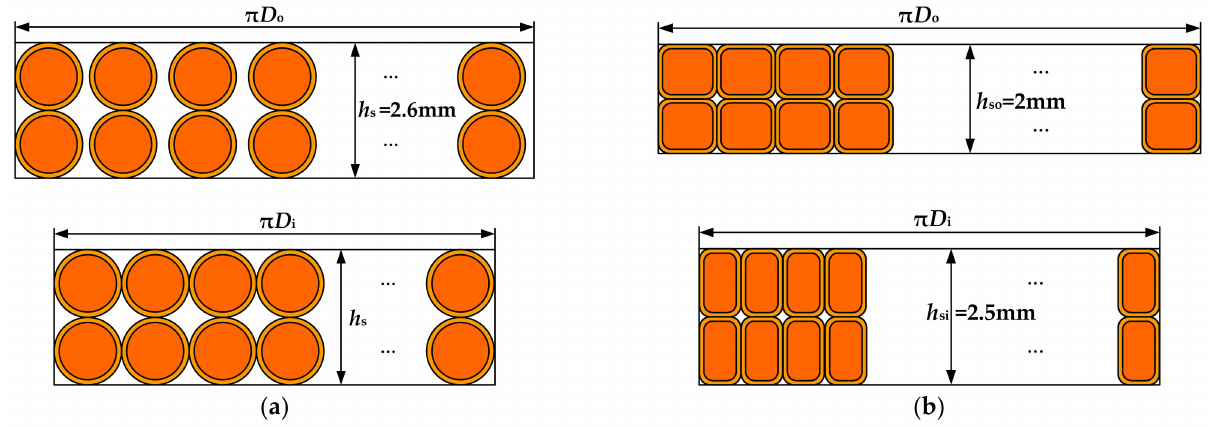
Figure 3. Distribution of effective conductors: ( a ) round conductors; ( b ) wedge-shaped